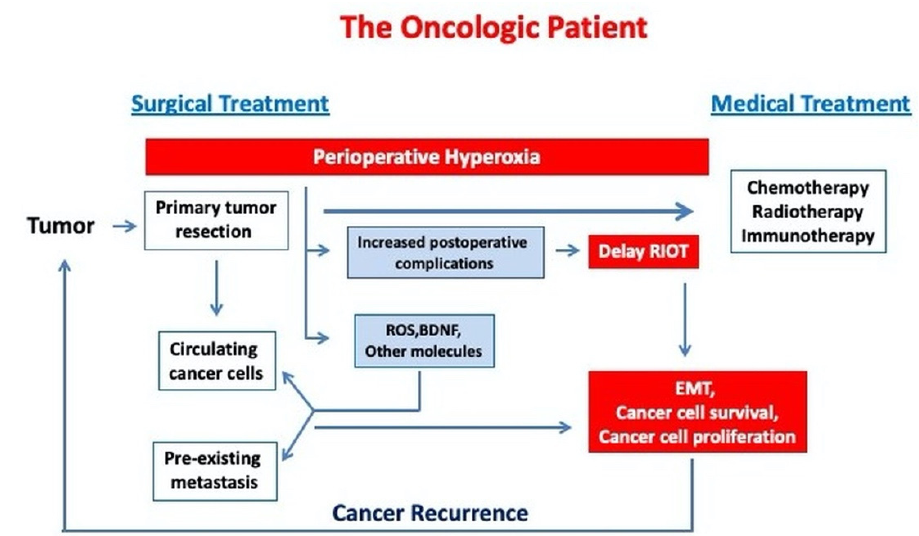
Figure 1. Perioperative hyperoxia may induce cancer progression in oncological patients by increas- ing cancer cell survival and EMT. (RIOT—return to the intended oncological treatment, EMT—epi- thelial mesenchymal transition).